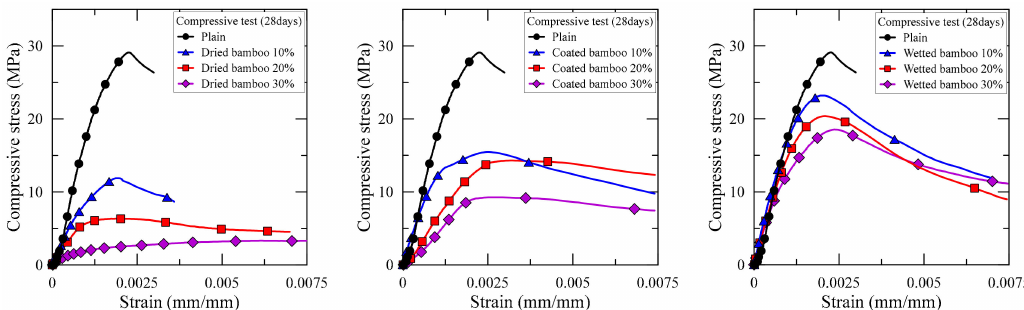
Figure 3. Compressive stress-strain